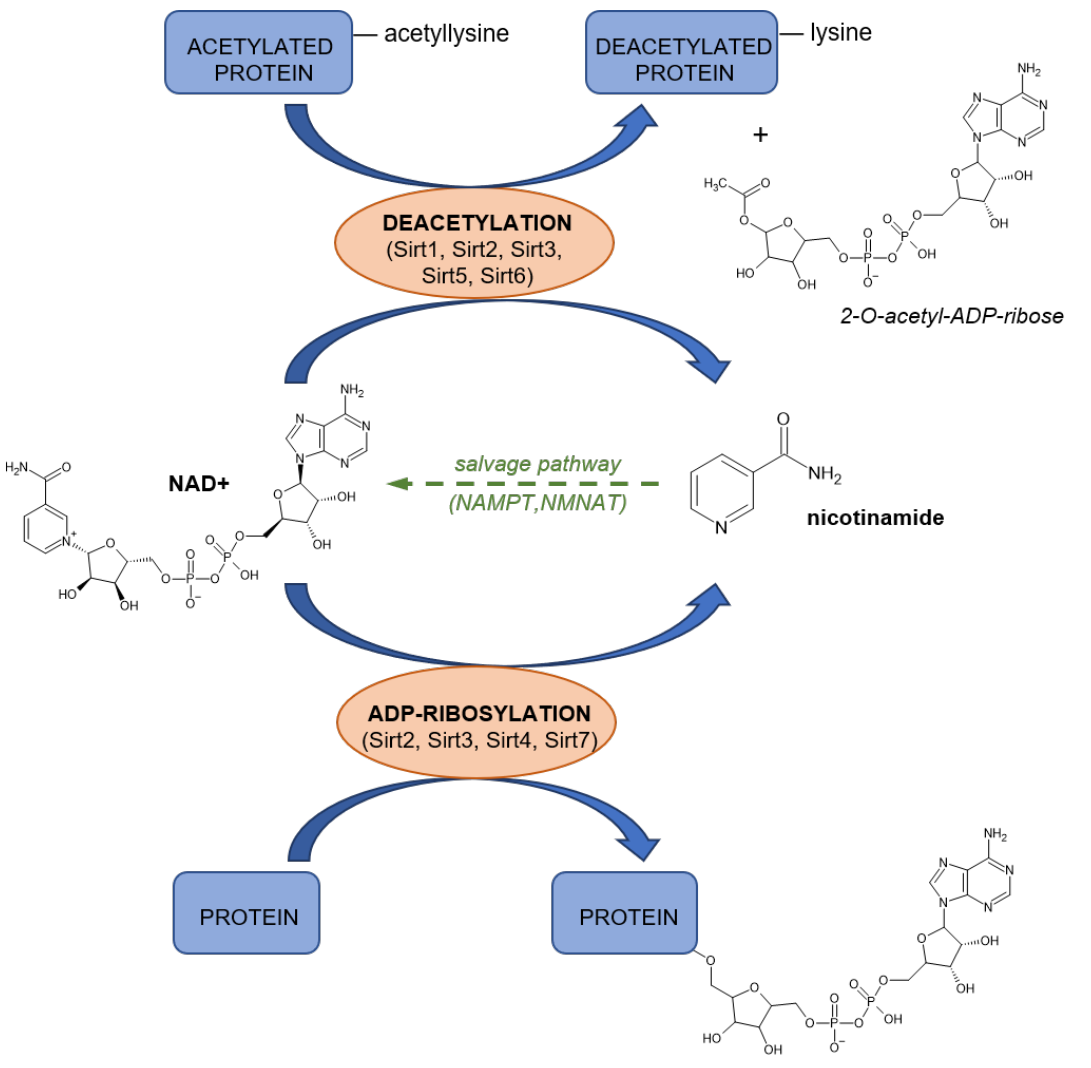
Figure 11. Mechanisms of NAD + depletion by sirtuins. NAD + is required for two types of protein modifications catalyzed by sirtuins. Nicotinamide is cleaved off in the process and regenerated into NAD via the salvage pathway.